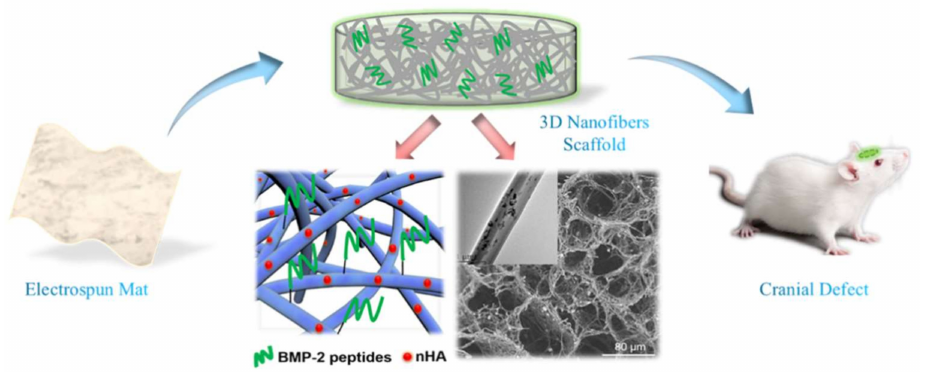
Figure 9. Three-dimensional (3D) electrospun nanofibrous sca ff old for rat cranial bone regeneration [23]. Reproduced with permission from Elsevier,